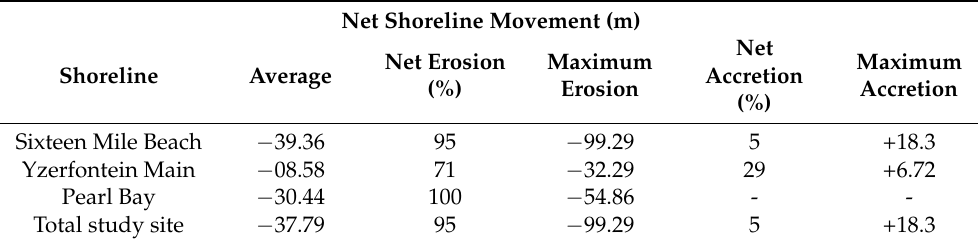
Figure 4. ( a ) Map of net shoreline movement (NSM) along the study site with warm colors represent- ing erosion and cool colors representing accretion. ( b ) Graph of NSM vs. 100 m-transects along the coast. Table 5. Summary of net shoreline movement (NSM) to the study site shoreline and its three beaches with landward movement as negative and seaward movement as